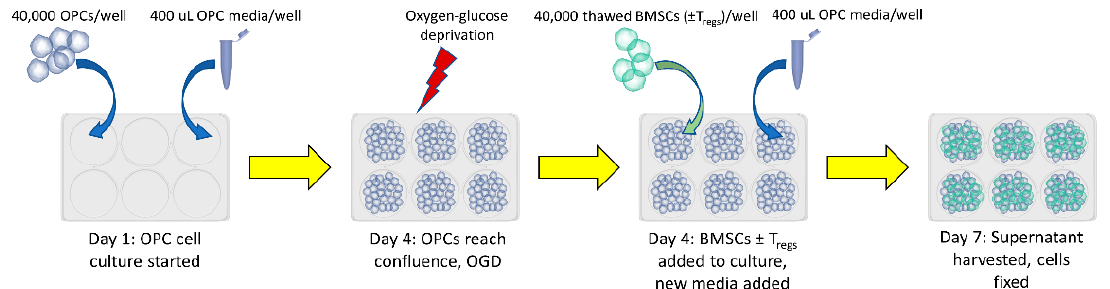
Figure 2. Oligodendrocyte progenitor cells (OPCs) were cultured for 3 days and then subjected to oxygen-glucose deprivation and reoxygenation (OGD / R). Bone marrow-derived stem cells (BMSCs) with or without T regs were then added directly into the cell culture, and both cell types were cultured together for 3 more days.